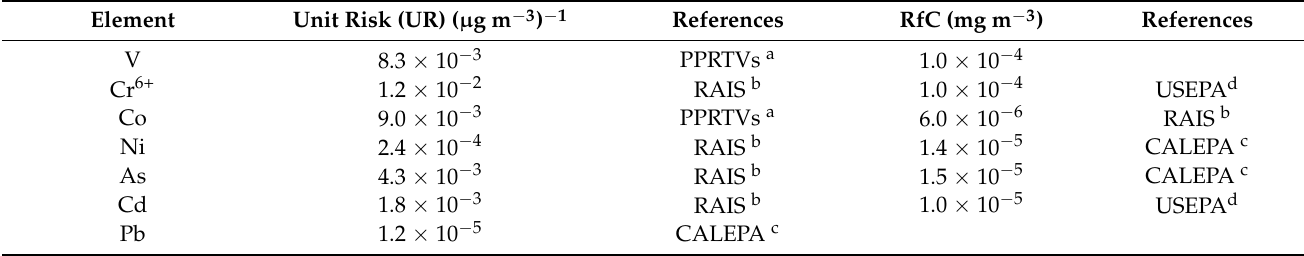
Table 2. The UR and RfC value of some potentially toxic